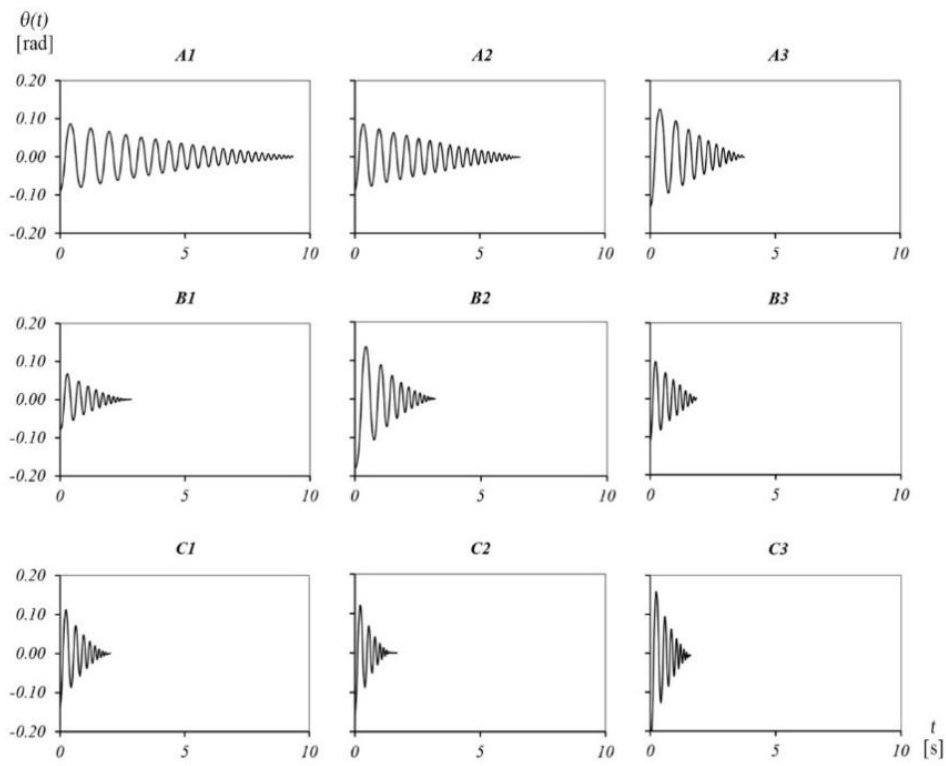
Figure 10. Free vibration tests for determining the coefficient of restitution.